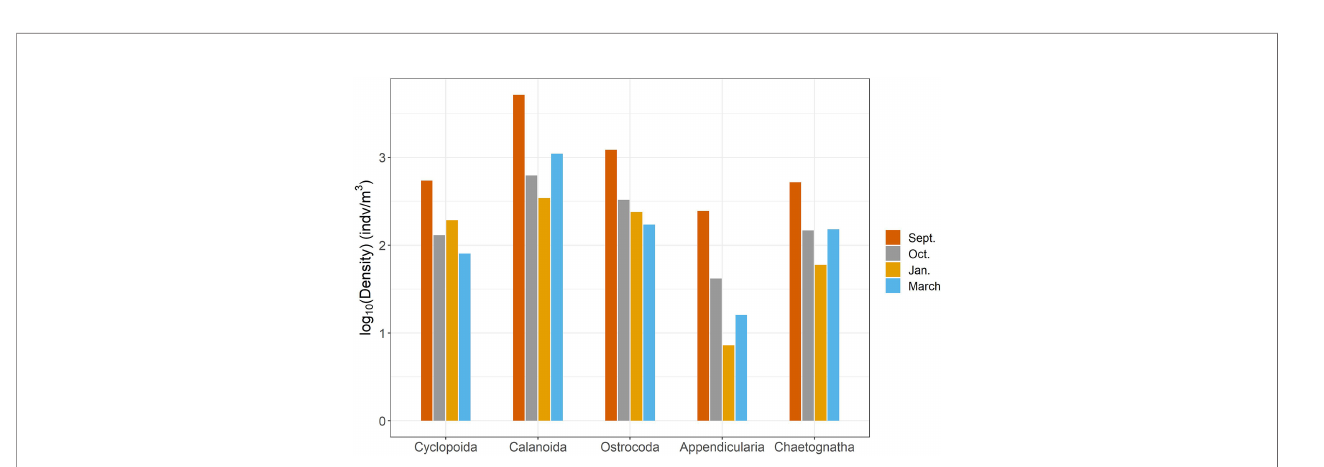
FIGURE 4 | Results of SIMPER analysis between cruises. Top fi vehighest contributing taxa to structuraldifferences were chosen to explain over 50% of the variance.